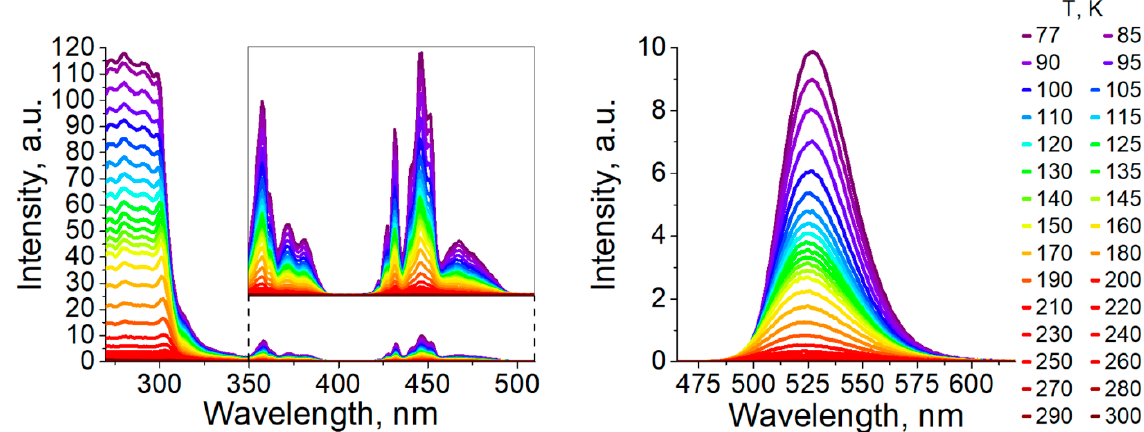
Figure 2. Temperature dependences of the photoluminescence excitation spectra ( λ Em = 527 nm) and photoluminescence spectra ( λ Ex = 447 nm) of 2 .